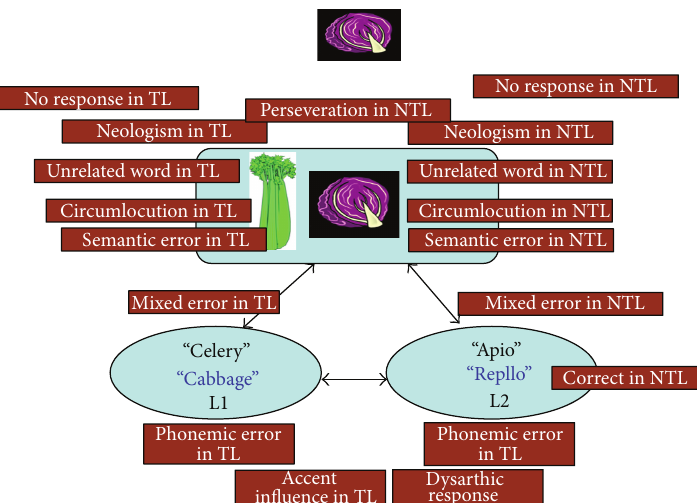
Figure 1: Schematic explaining the hypothesized locus of naming errors that is based on a two-step model of naming that includes semantic access and phonological access in the two languages. All error types may occur in the target language (TL) or nontarget language (NTL). No responses, perseverations, and neologisms are presumed to occur prior to semantic access of the target lemma. Unrelated word, circumlocutions, and semantic errors may occur due to varying degrees of incomplete access at the semantic representation level. Mixed errors (combinations of semantic and phonological errors) may occur due to impaired connections between semantic and language specific phonological levels. Phonemic errors, accent influences, and dysarthric responses are all presumed to occur after language specific phonological access has occurred. Cross-language translations are coded as correct responses in the nontarget language.